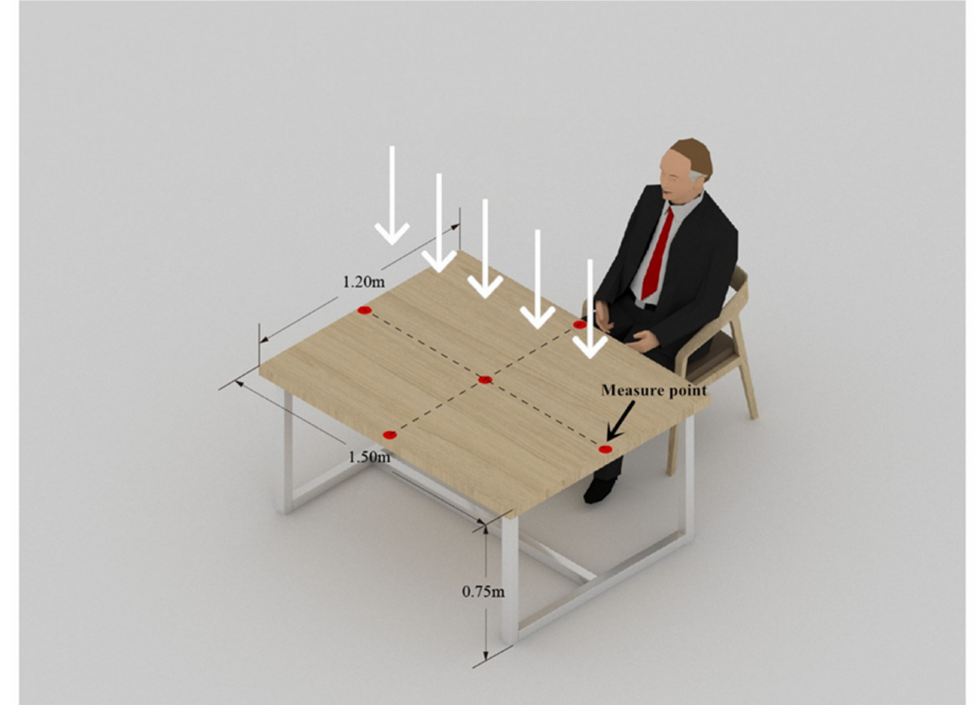
Figure 3. Task area measurement point layout.